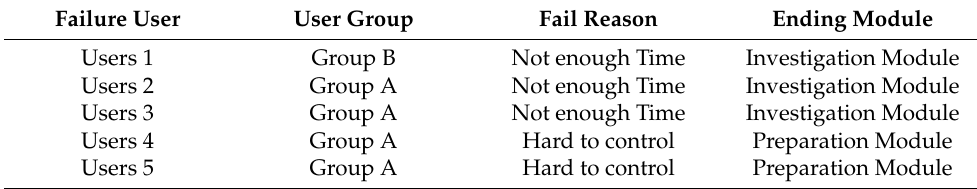
Table 6. Failure User Data